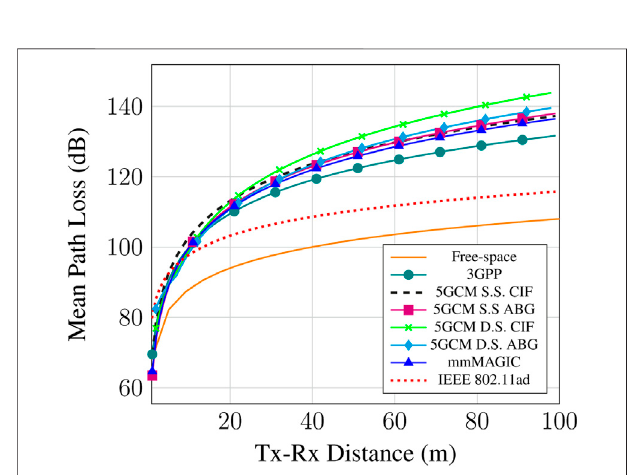
FIGURE 7 | Path loss versus Tx-Rx distance comparison among eight different channel models in NLOS InH of fi ce